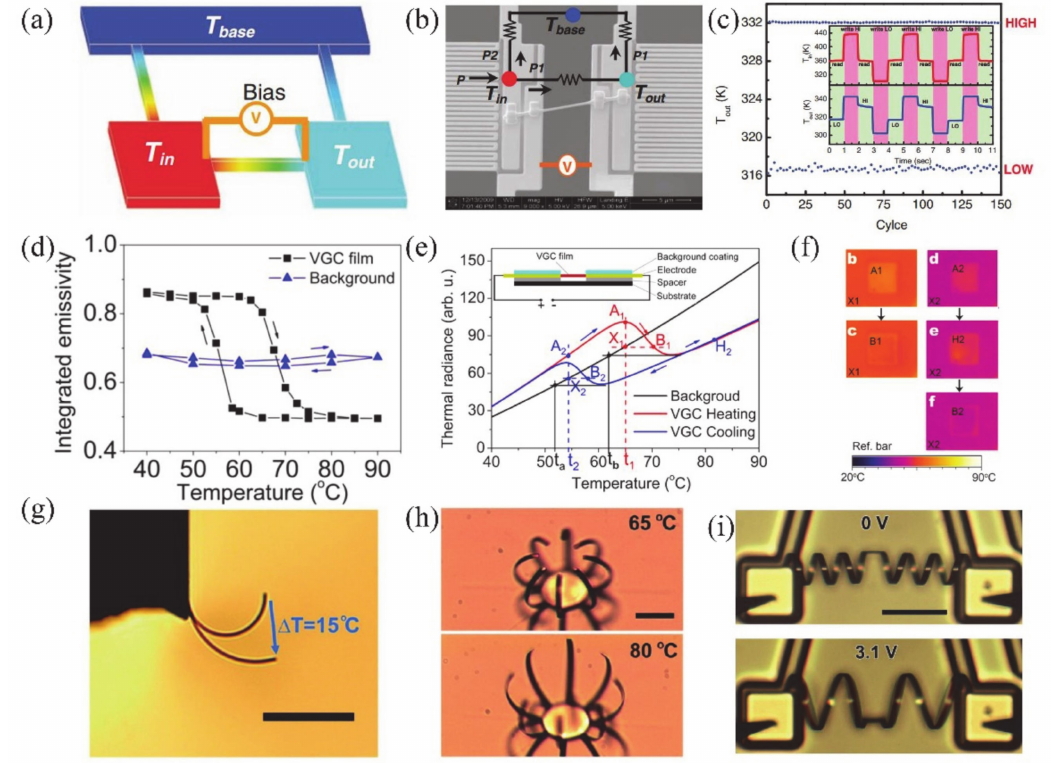
Figure 27. ( a ) A schematic illustration of a thermal memory device. ( b ) SEM image of a thermal memory device. ( c ) High/low temperature status over 150 cycles by using a 1 s heating pulse and 1 s cooling pulse; the inset shows the process of write–high-read–write–low-read over three cycles. Reproduced from [184], with permission from John Wiley and Sons, 2011. ( d ) Temperature emissivity of VGC film on black tape and background coating. ( e ) Thermal radiance from the background (black line) coating and free-standing VGC film, (red line refers to heating process, blue line refers to cooling process), and the inset shows the structure of VGC-based device; and ( f ) the thermal images of the direct and delayed heating camouflage processes are shown on the right. Reproduced from [186], with permission from American Chemical Society, 2015. ( g ) Optical image of VO 2 cantilever change with a temperature change of 15 ◦ C; the scale bar is 50 µ m. ( h ) Optical image of VO 2 microactuator with a “palm” structure under temperatures of 65 ◦ C and 80 ◦ C. Reproduced from [188], American Chemical Society, 2012. ( i ) The geometry of VO 2 double coil under at 0 V and 3.1 V; the scale bar is 100 µ m. Reproduced from [189], with permission from John Wiley and Sons.